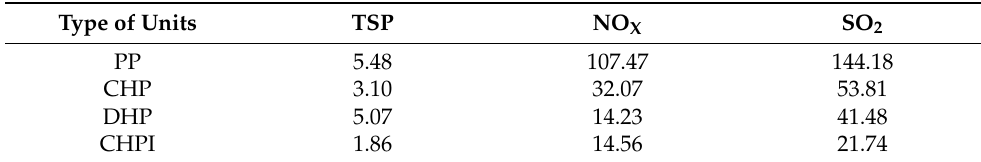
Table 4. Annual emissions of the main pollutants in Poland in 2018 from public power plants (PP), public combined heat and power plants (CHP), district heating plants (DHP), and industrial combined heat and power plants (CHPI) (kt).